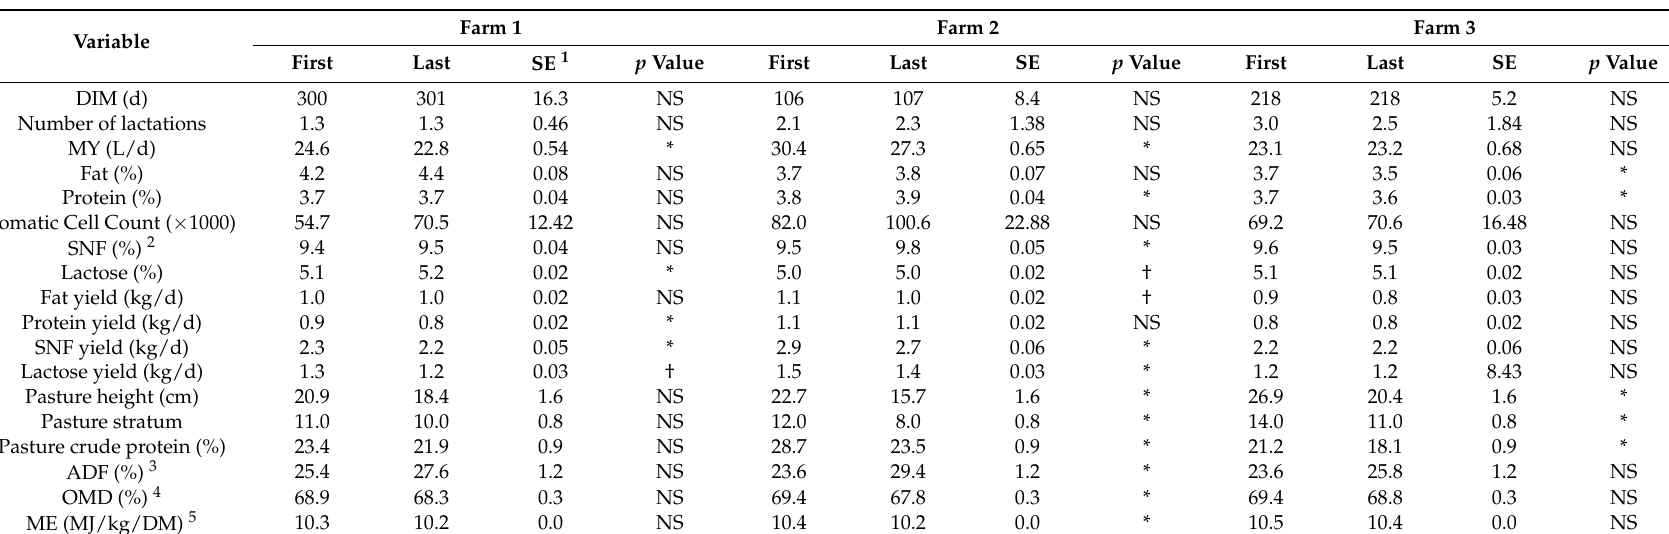
Table 4. Mean days in milk (d), lactation number, milk yield (L/d) and composition (%), pasture height (cm), and pasture nutritive value accessed for the first 50 and last 50 cows milked for three